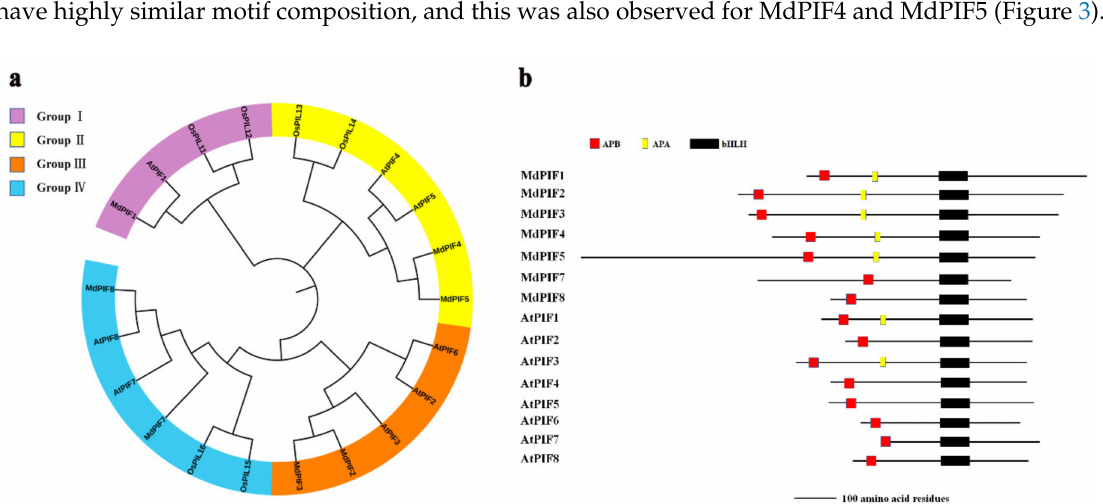
Figure 2. AnalysisofphylogeneticrelationshipandconserveddomainsofMdPIFs. ( a )Unrootedphylogenetic tree of PIF proteins from Malus domestica , Arabidopsis thaliana , and Oryza sativa. MEGA5.1 was used to construct the phylogenetic tree based on the PIF protein sequences, and the four distinct subgroups of PIF proteins are shown. Interactive Tree of Life (iTOL) online software was used to annotate and review the phylogenic tree. AtPIF1: AT2G20180; AtPIF2: AT2G46970; AtPIF3: AT1G09530; AtPIF4: AT2G43010; AtPIF5: AT3G59060; AtPIF6: AT3G62090; AtPIF7: AT5G61270; AtPIF8: AT4G00050; OsPIL11: Os12g0610200; OsPIL12: Os03g0639300; OsPIL13: Os03g0782500; OsPIL14: Os07g0143200; OsPIL15: Os01g0286100; OsPIL16: Os05g0139100. ( b ) Motif comparisons of the MdPIF and AtPIF proteins. The presence of APA, APB, and bHLH motif is depicted as boxes. Bar = 100 amino acid